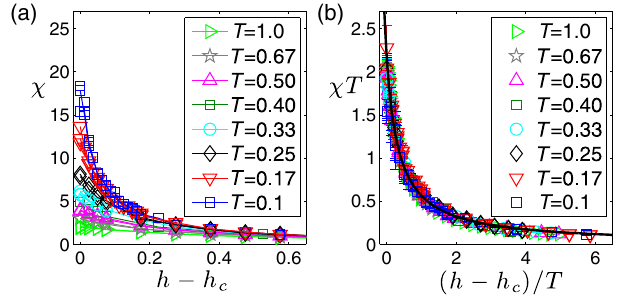
FIG. 6. (a) Nematic susceptibility χ ð h; T Þ as a function of h − h for system sizes L ¼ 16 , 20, and 24 at various temper- c atures. (b) The same data, scaled appropriately for λ ¼ 1 and γ ¼ 1 , collapse on a single curve. The black curve is the function F ð x Þ ¼ 2 . 1 = ð 1 þ 2 . 9 x Þ .